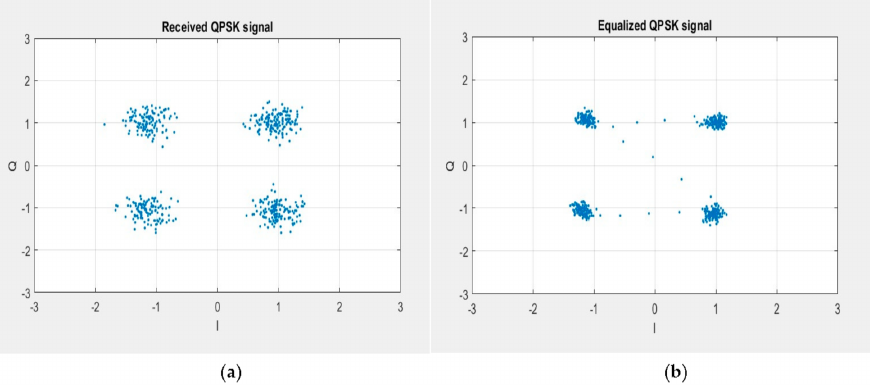
Figure 9. EVM measurements for the QPSK modulation using LMS equalization (100 km SMF link). ( a ) Constellation diagram for QPSK before equalization with EVM 18.7%. ( b ) Constellation diagram for QPSK after LMS equalization with EVM 17%.